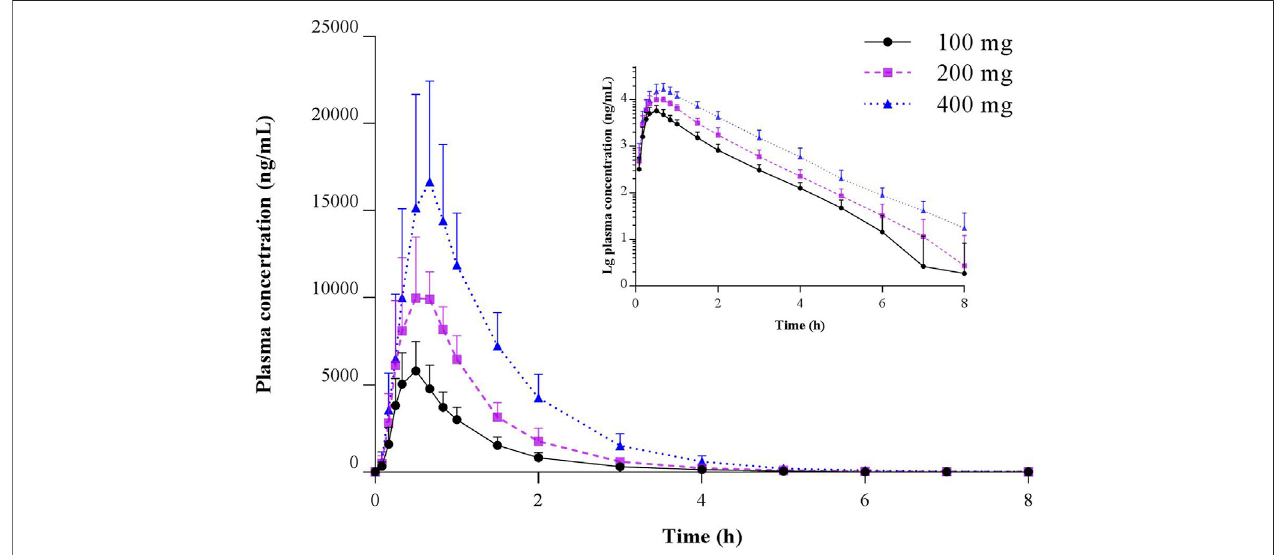
FIGURE 2 | Mean (SD) and semilogarithmic scaled plasma concentration – time pro fi les of TBPM-PI after a single oral dose of 100, 200, or 400 mg in healthy Chinese subjects ( n (cid:2) 12 for each dose).